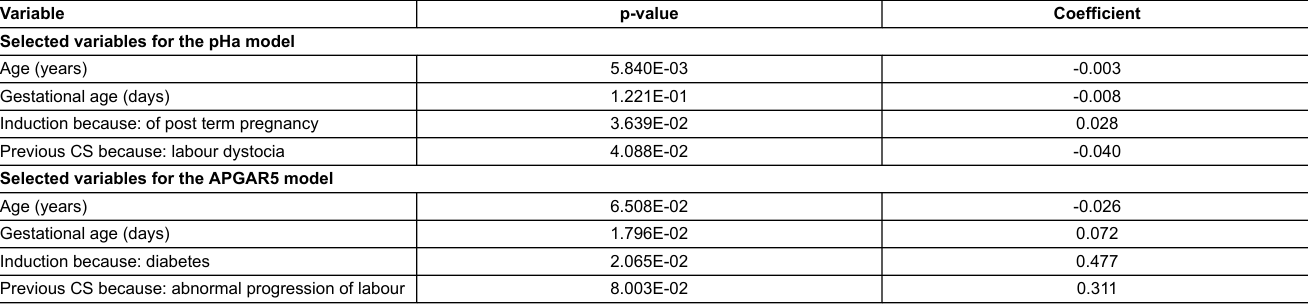
Table S1: Detailed analysis of clinically non-significant compound models in the investigated cohorts (induction method catheter and oxytocin after caesarean